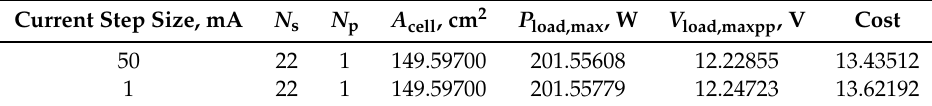
Table 19. Best solution (stack design) of